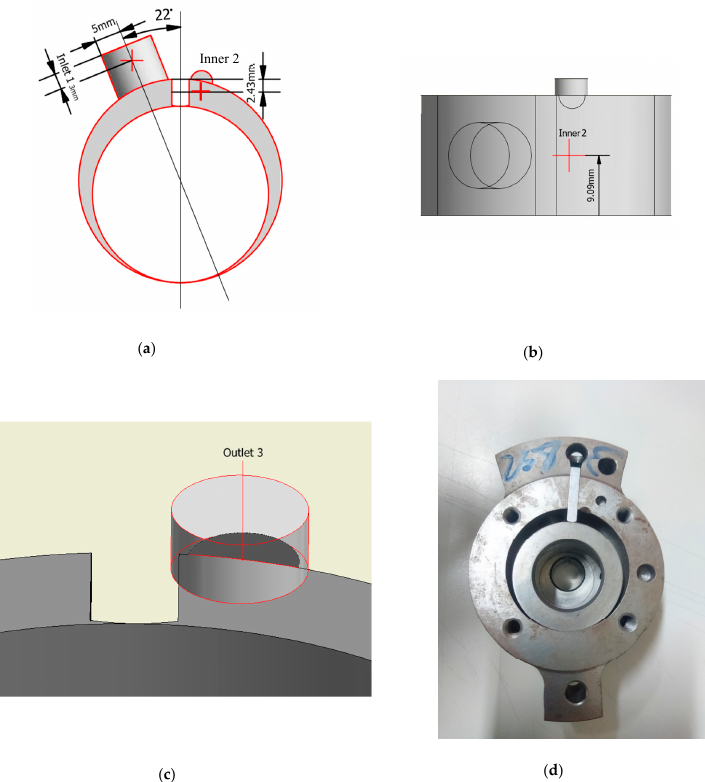
Figure 3. The locations of three representative measured points ( a) Inlet 1, ( b ) Inner 2, ( c ) Outlet 3 ( d ) assembly of real parts.